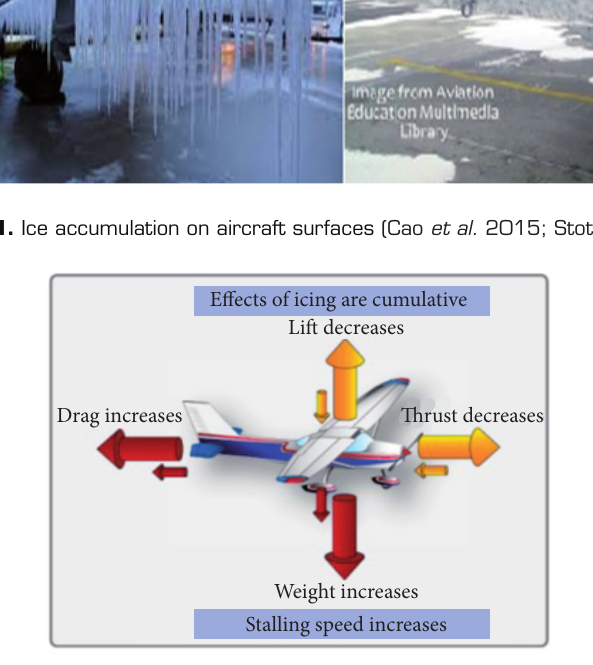
Figure 12. Effects of icing accumulation on aircraft surfaces (Stothers 2013; Kind et al.